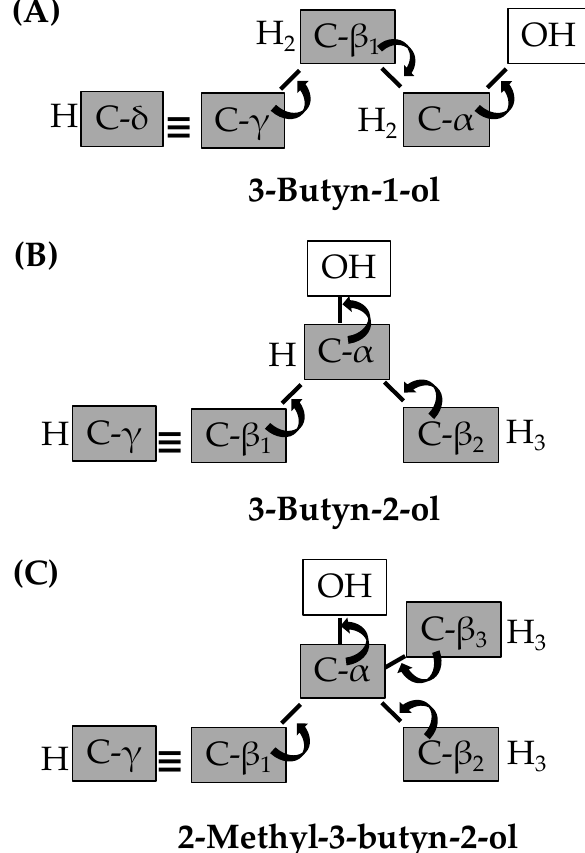
Figure 1. Classification of ( A ) primary, ( B ) secondary and ( C ) tertiary C 4 alkynols. Note : Arrows represent associated charge transfer effect.